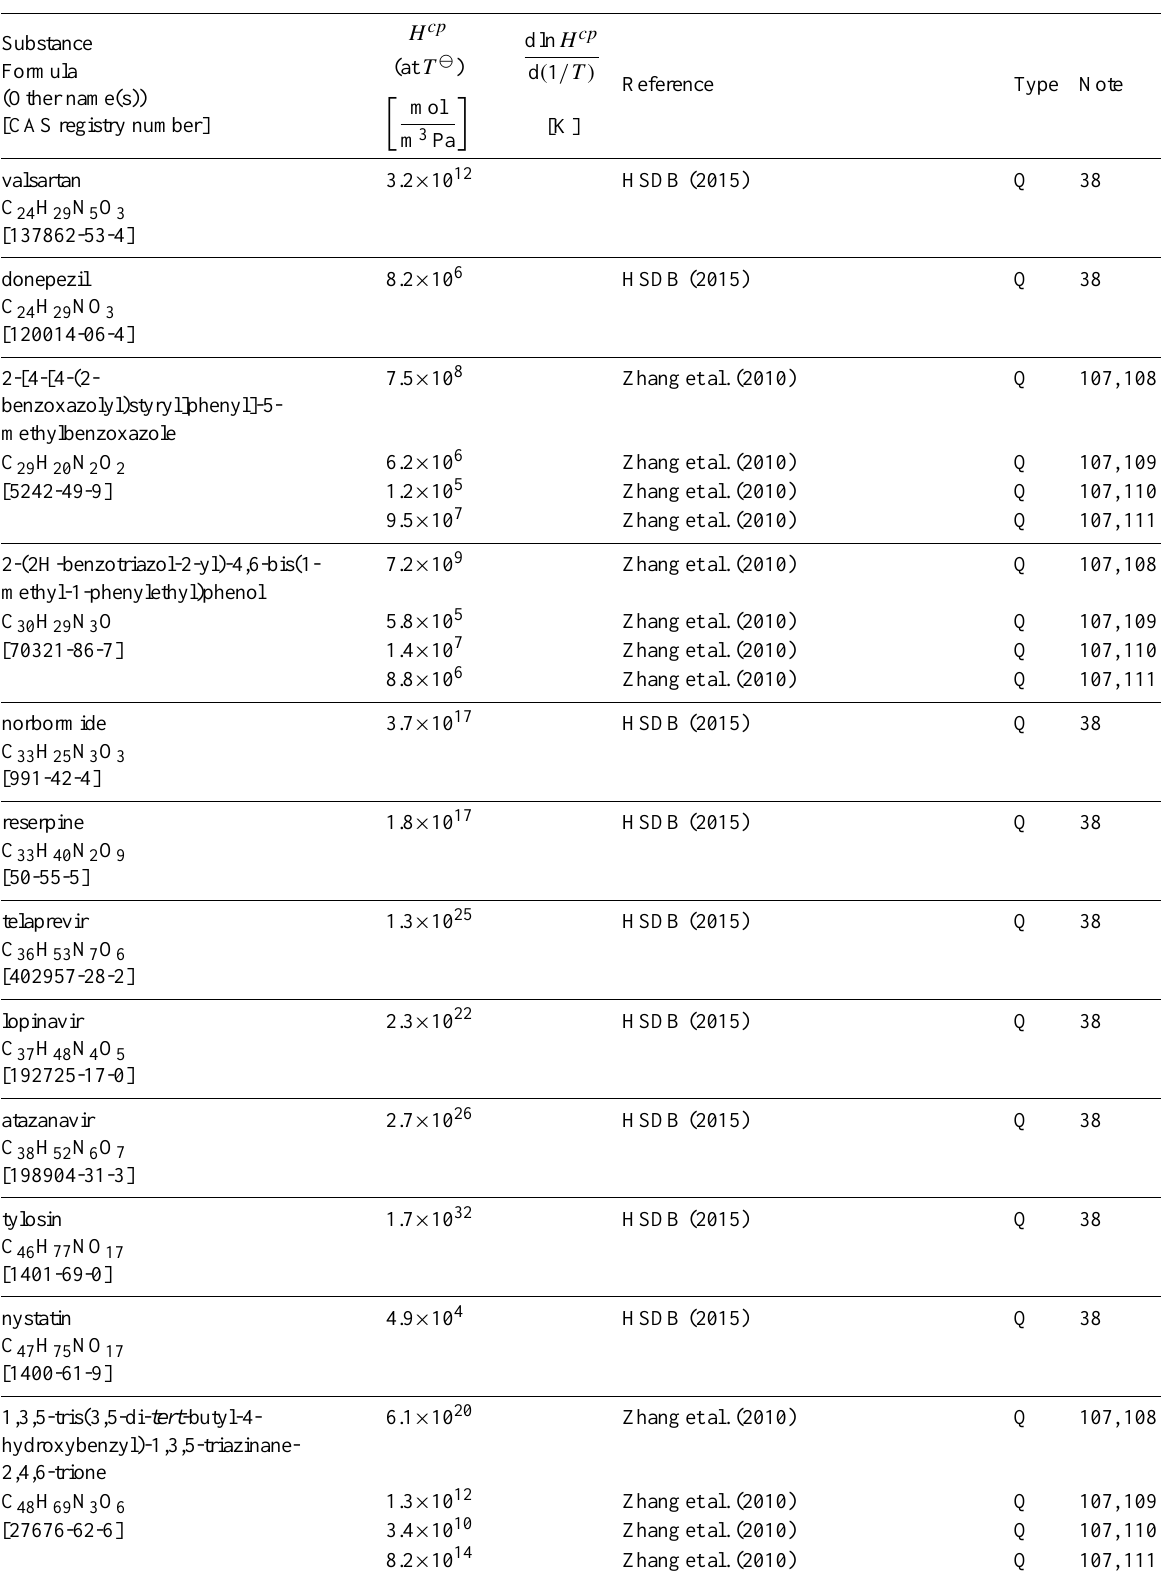
Table 6: Henry’s law constants for water as solvent